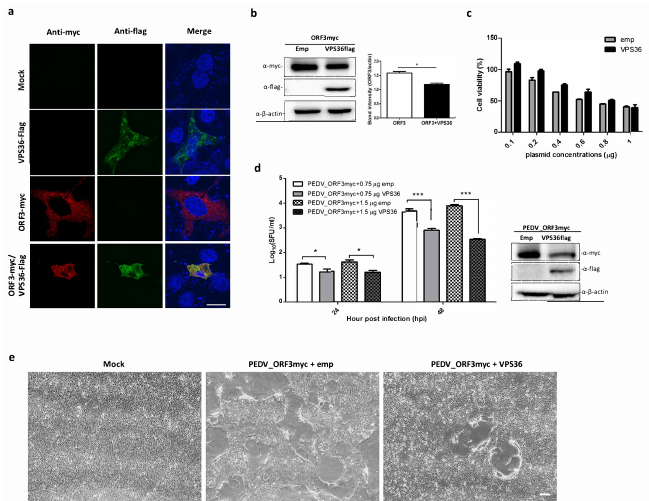
Figure 5. Co-expression of ORF3 and VPS36 and inhibitory e ff ect of VPS36 to PEDVAV12_ORF3myc replication in VeroE6-APN cells. VeroE6-APN cells were transfected with the plasmids expressing ORF3 and VPS36 or mock transfected. At 24 hpt, cell lysates were subjected to ( a ) immunofluorescence staining to visualize protein co-localization and ( b ) western analysis to determine ORF3 expression level in transfected cells. ( c ) VeroE6-APN cells grown in a 96-well plate were transfected with plasmid expressing VPS36 at di ff erent concentrations. At 24 hpt, cell viability (CCK-8 assay) was performed. The absorbance data was compared between mock transfected and transfected cells. The results are expressed as the mean of three independent experiments ± standard error of means (SEM). ( d ) PEDV AV12 _ORF3myc growth kinetics in VPS36 overexpressed cells. The plasmid expressing VPS36 at di ff erent concentrations (0.75 and 1.5 µ g) were transfected into VeroE6-APN cells. At 8 hpt, the cells were washed and infected with PEDV AV12 _ORF3myc at MOI of 0.1. Supernatants were collected for virus titration (SFU / mL) at indicated time points. *, p < 0.05 ***, p < 0.001. ( e ) Syncytia formation of PEDV AV12 _ORF3myc infected VeroE6-APN cells at 48 hpi. The scale bar is 200 µ